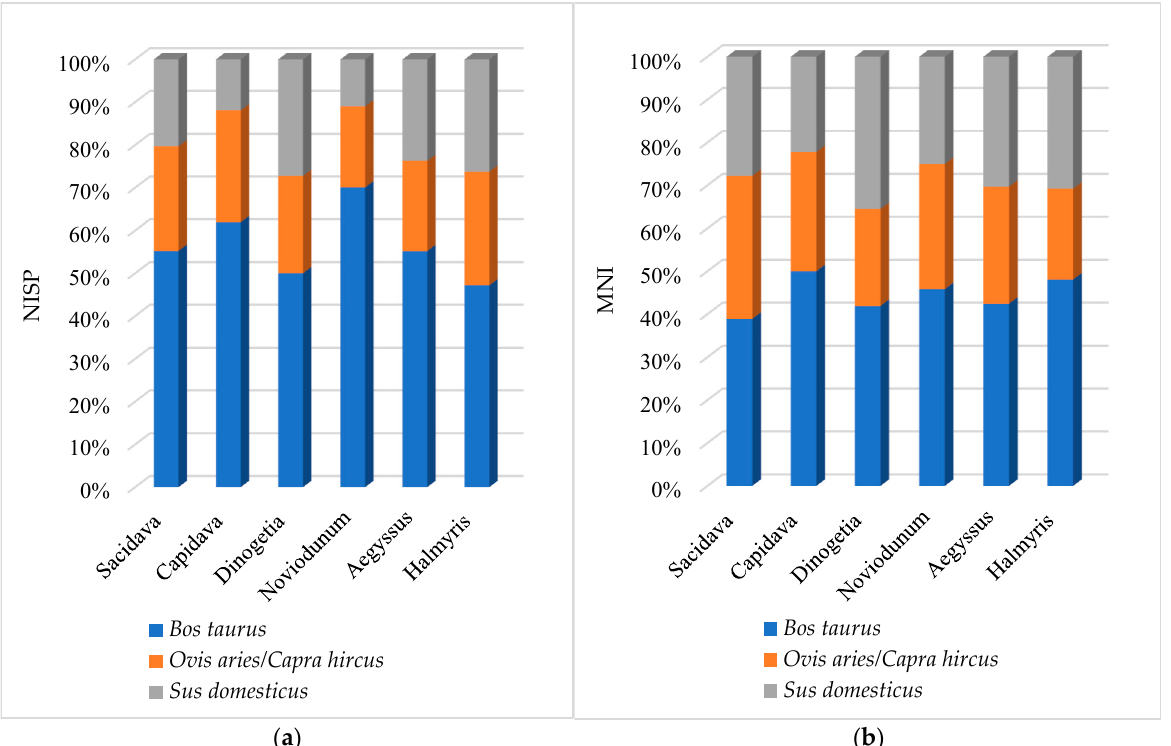
Figure 5. Proportions of cattle, sheep/goat, and pig: ( a ) NISP—number of identified specimens; ( b ) MNI—minimal number of individuals.